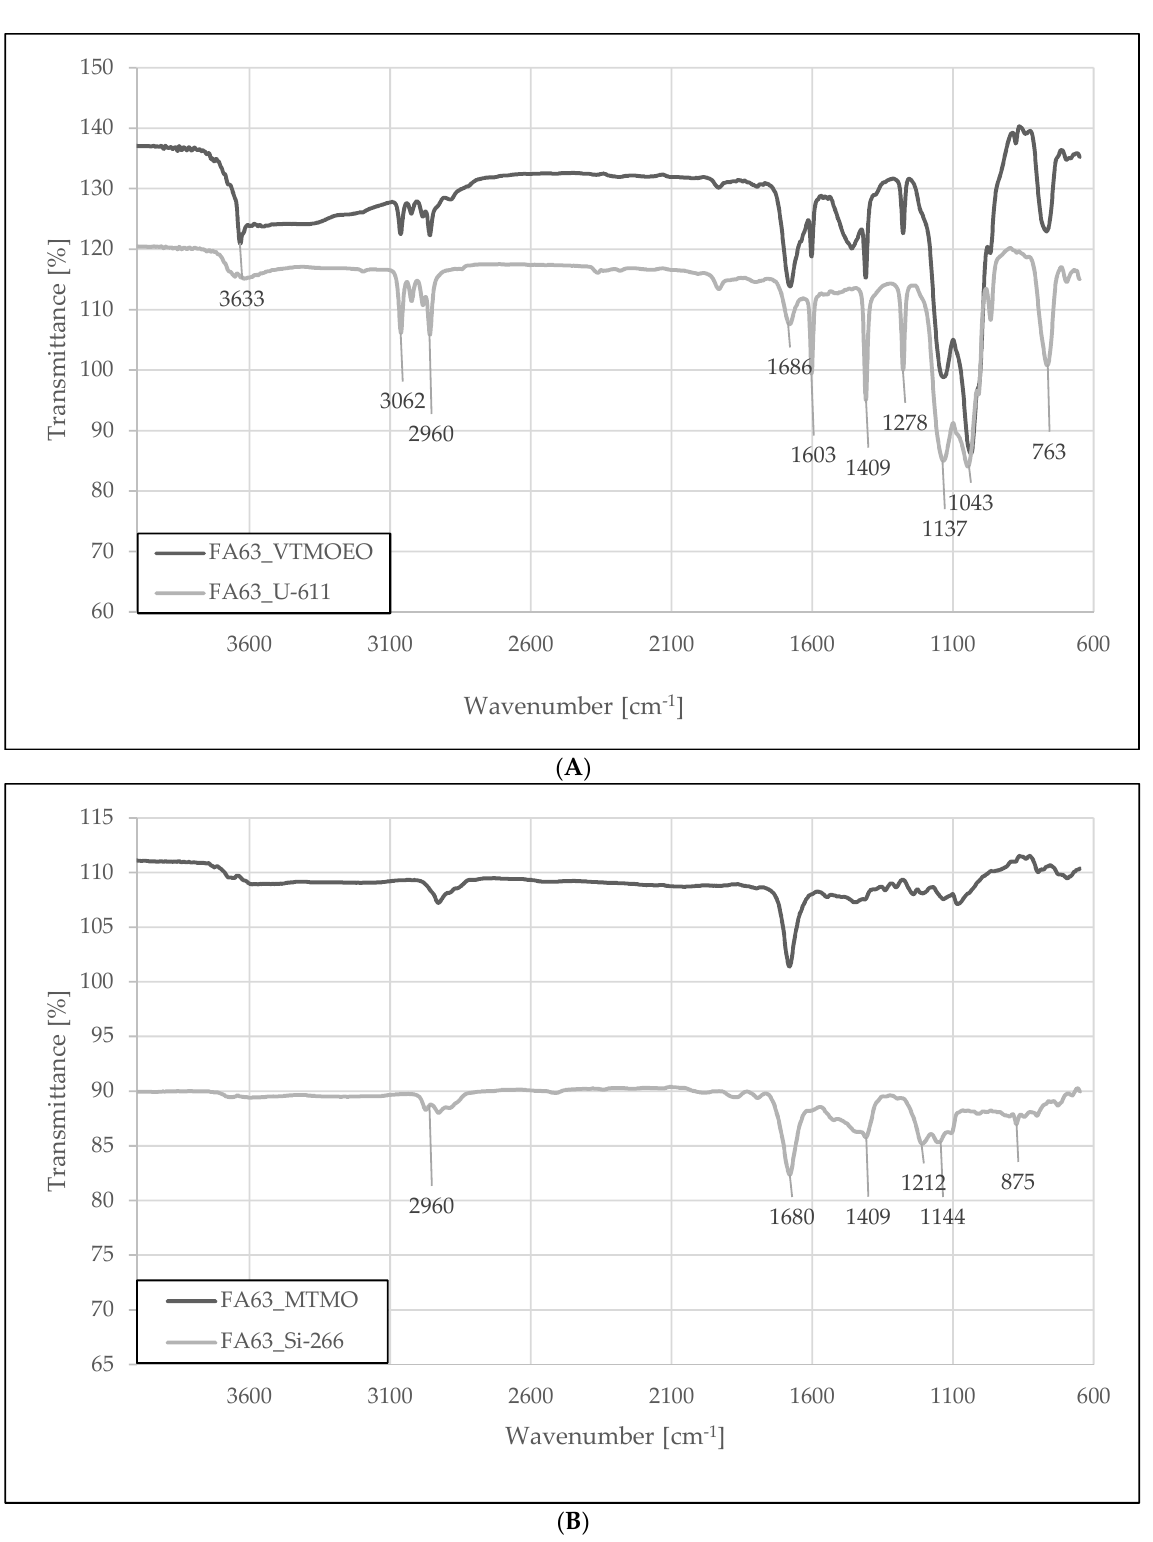
Figure 2. Fourier transform infrared (FTIR) spectroscopy analysis of FA-63 fraction modified by vinyl ( A ) and sulfur-containing ( B ) silanes. The infrared spectrum of U-50 (3-glycidoxypropyltriethoxysilane) functionalized ash sample is shown in Figure 3.